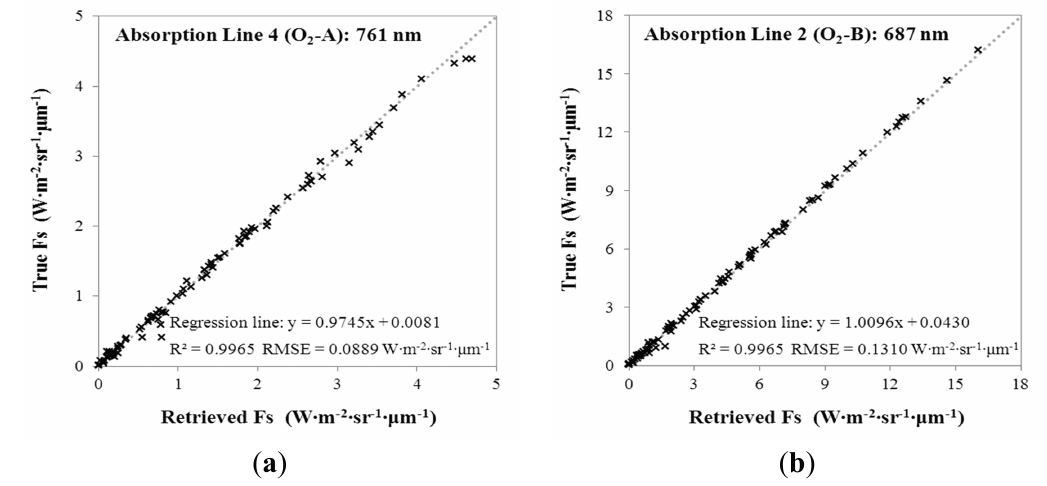
Figure 4. Scatter diagrams of retrieved versus “true” Fs values at ( a ) 761 nm, ( b ) 687